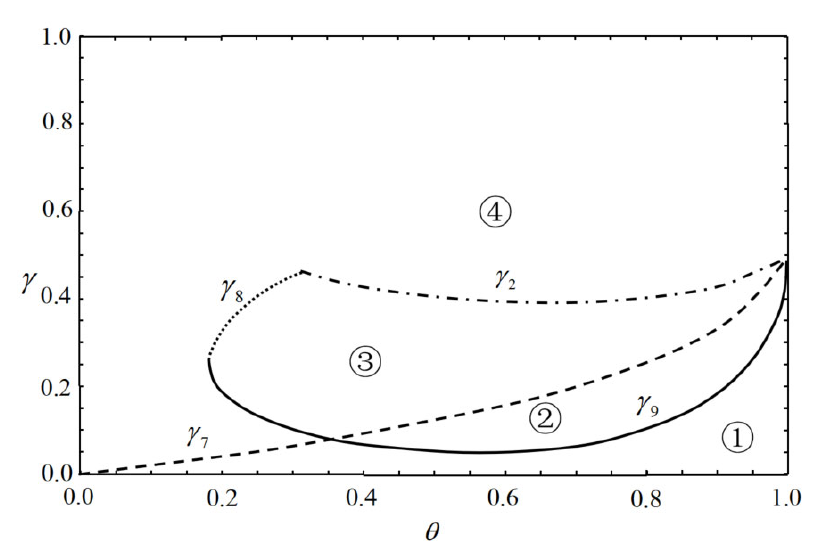
Figure 5. The   area graph. Figure 5. The γ − θ area graph.